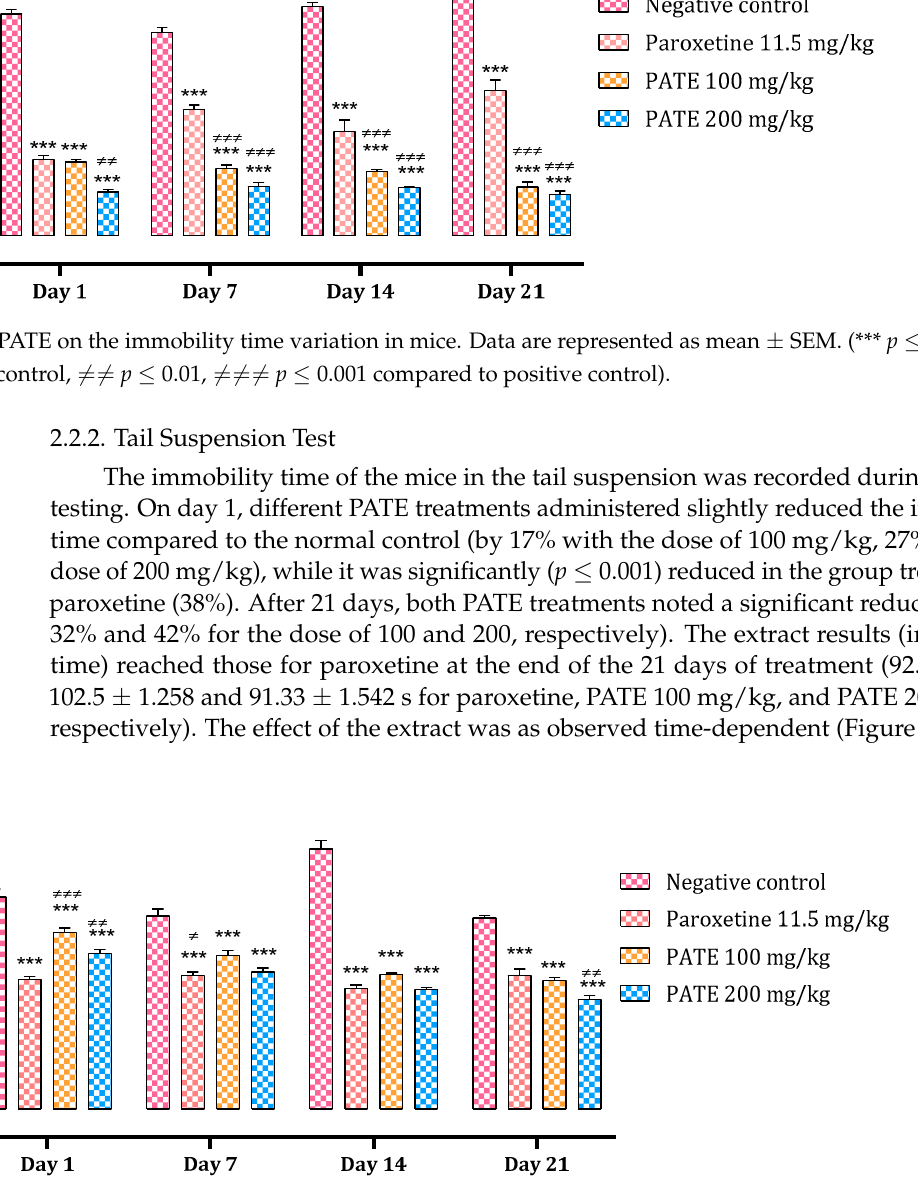
Figure 3. Downtime of the animals in TST. Data are represented as mean ± SEM. (*** p ≤ 0.001 compared to the negative control group. ≠ p ≤ 0.05, ≠≠ p ≤ 0.01, ≠≠≠ p ≤ 0.001 compared to the paroxetine group).